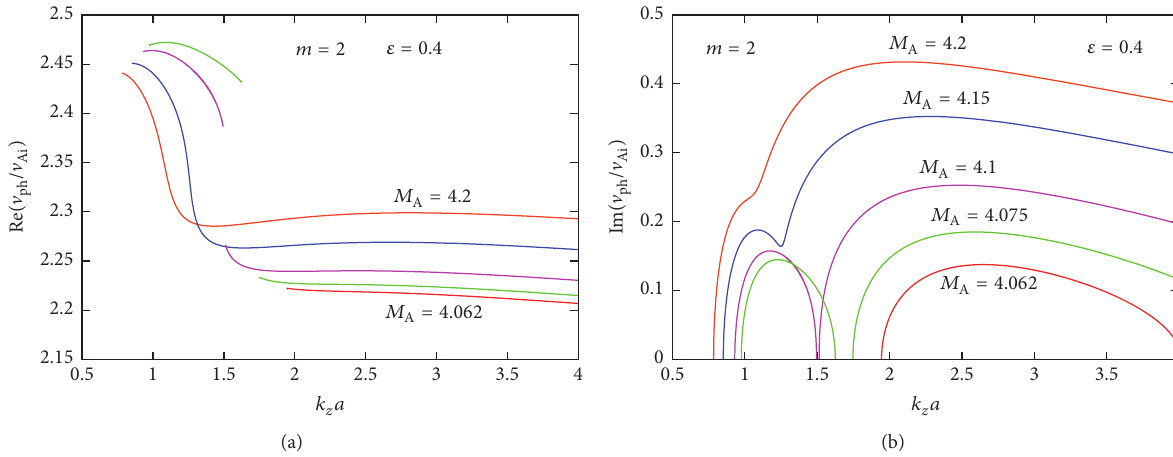
Figure 10: (a) Dispersion curves of unstable ( 𝑚 = 2 ) MHD mode propagating in a moving twisted flux tube of incompressible plasma (modeling jet #11) at the same parameters as in Figure 8 and for 𝑀 A = 4.2 , 4.15, 4.1, 4.075, and 4.062. (b) The normalized growth rates for the same values of 𝑀 A .